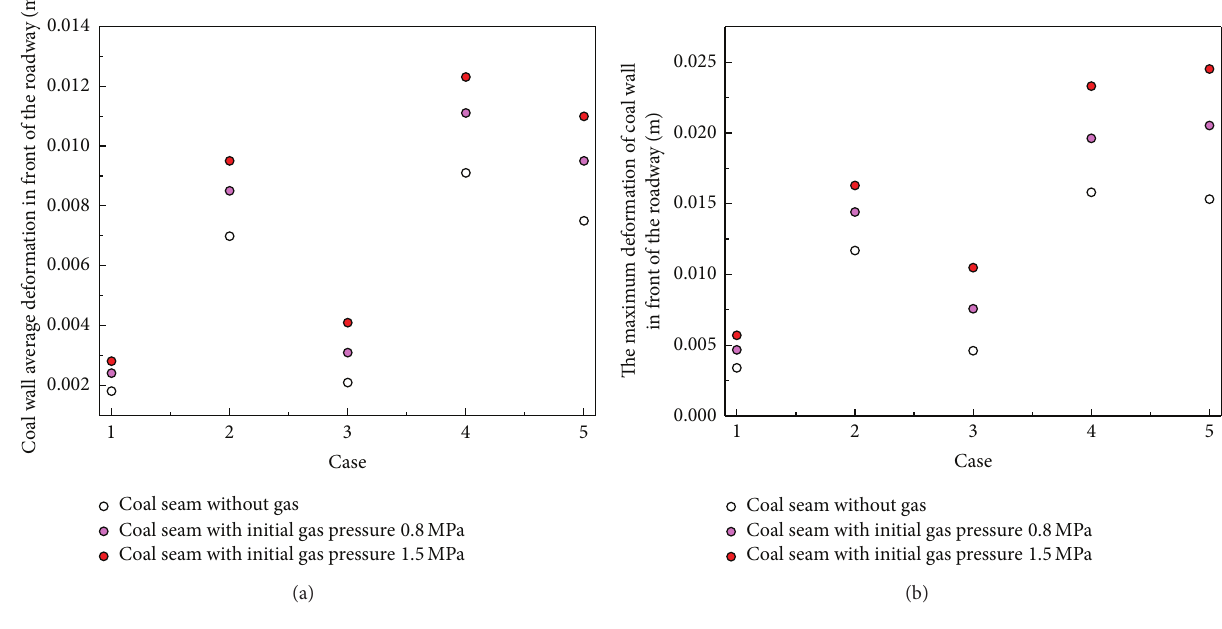
Figure 3: The deformation of the coal wall in front of the